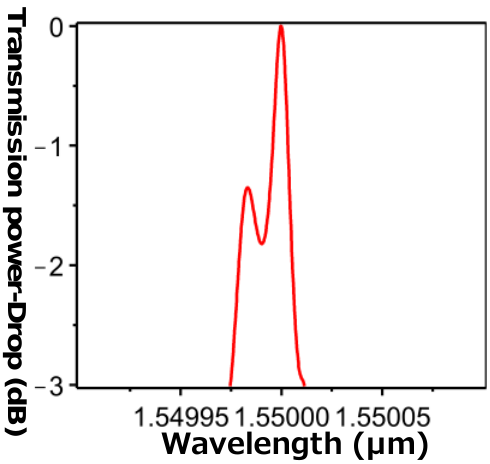
Figure 18. Spectrum of the FBG-OADM for the −3 dB bandwidth (FWHM).